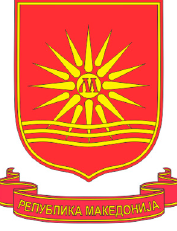
Figure 6. Proposal by Bozho Rajchevski.